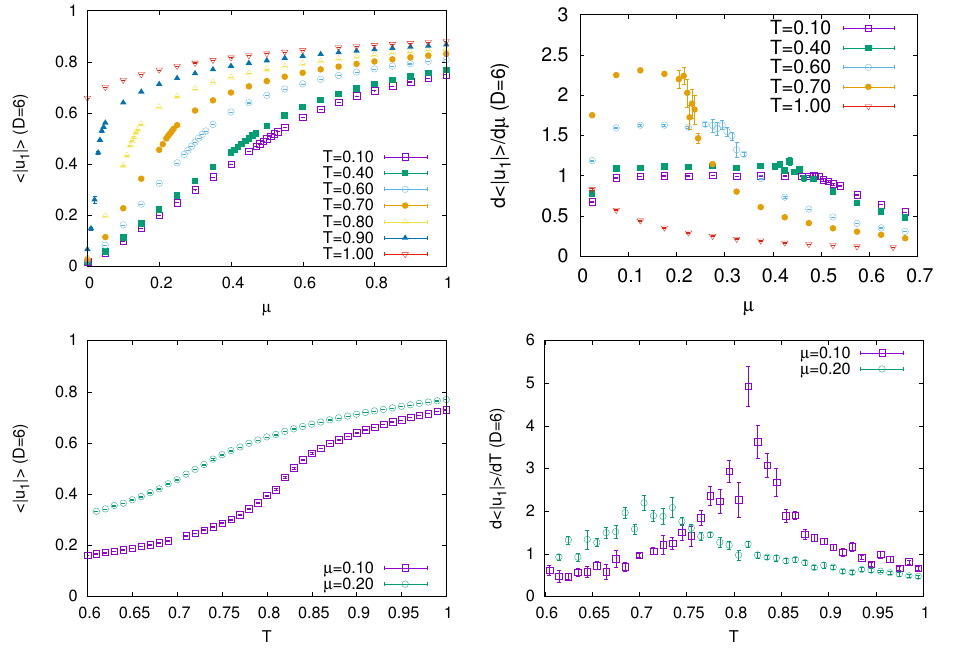
Figure 3 . hj u 1 ji (left) and d hj u 1 ji